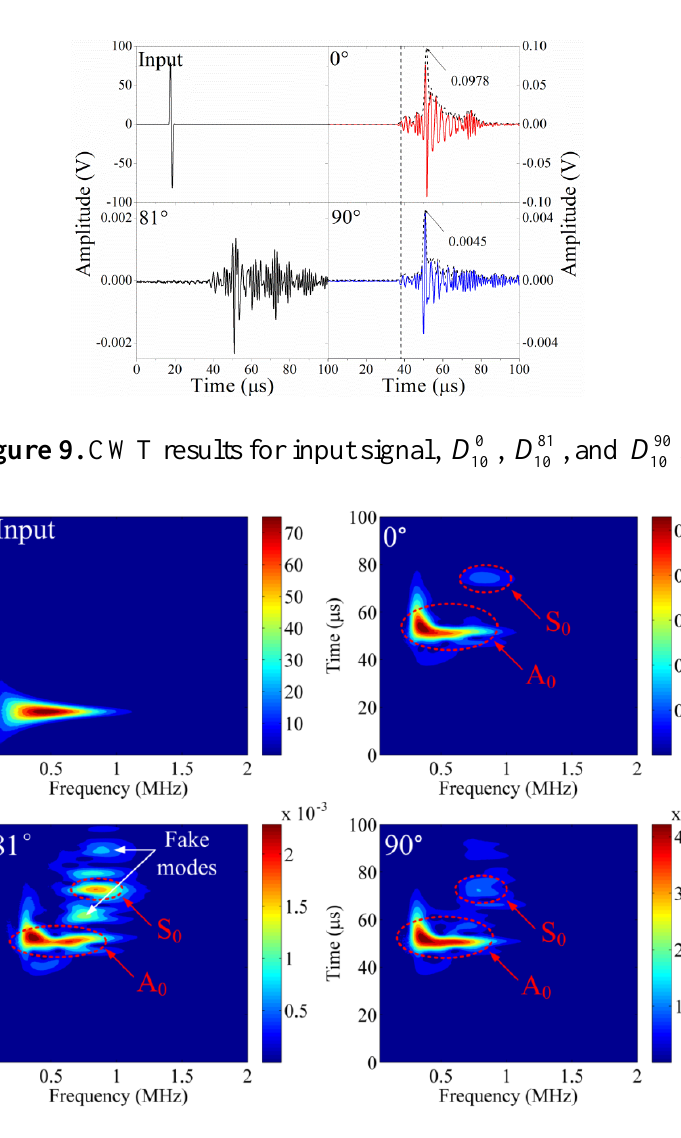
Figure 8. Waveforms of input signal,